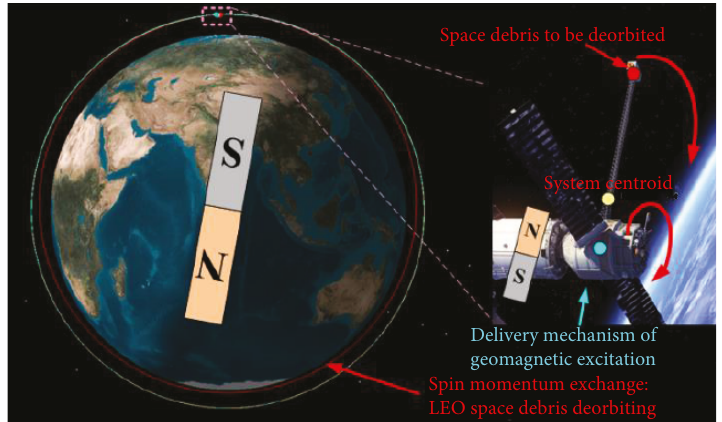
Figure 1: Diagram of LEO space debris deorbiting by geomagnetic excitation.